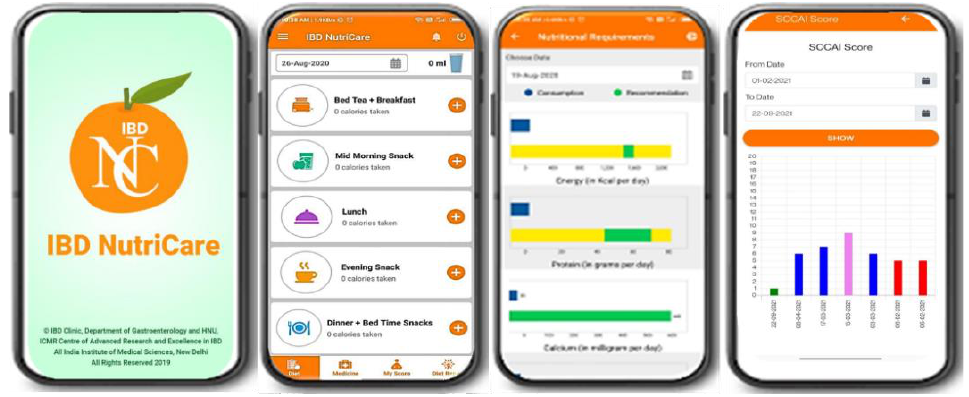
Figure 2. Screenshots of the features of the IBD NutriCare